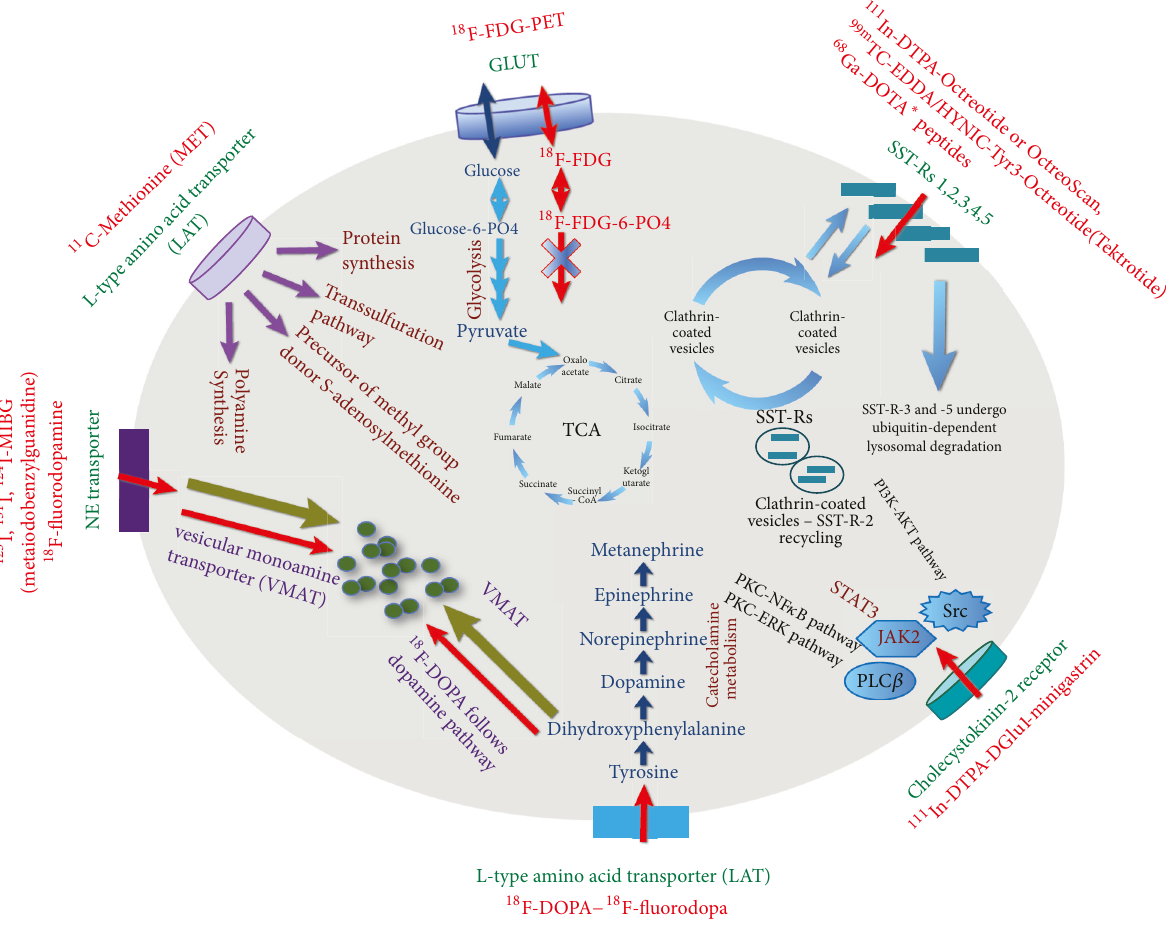
Figure 2: Mechanisms of uptake and localization of different radiopharmaceuticals, which can be used for medullary thyroid carcinoma. Please see explanations in the